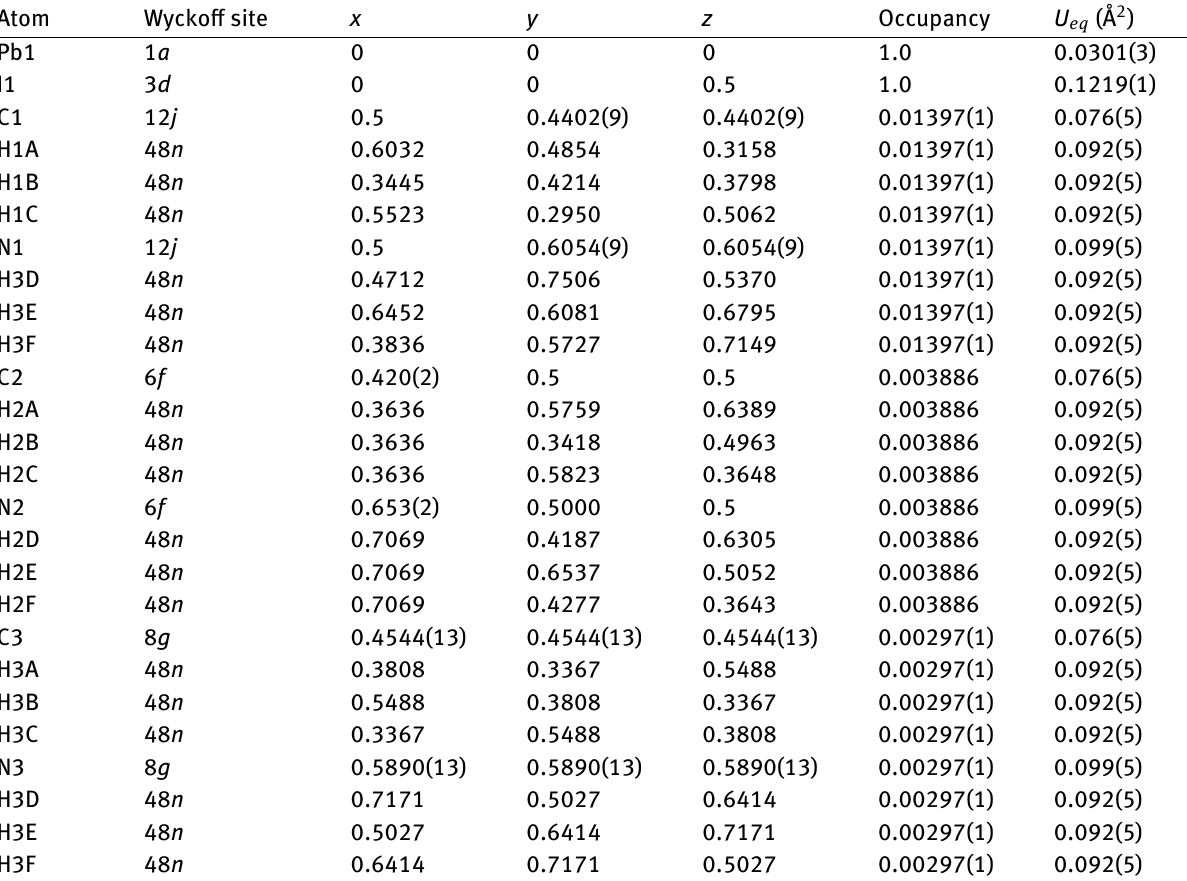
Table 4: Structural parameters of cubic CH 3 NH 3 PbI 3 . For space group Pm 3 m (221), a = 6.315(3) Å at 350 K. U eq is equivalent isotropic displacement parameters. Reproduced with permission [159]. Copyright 2016, American Chemical Society.